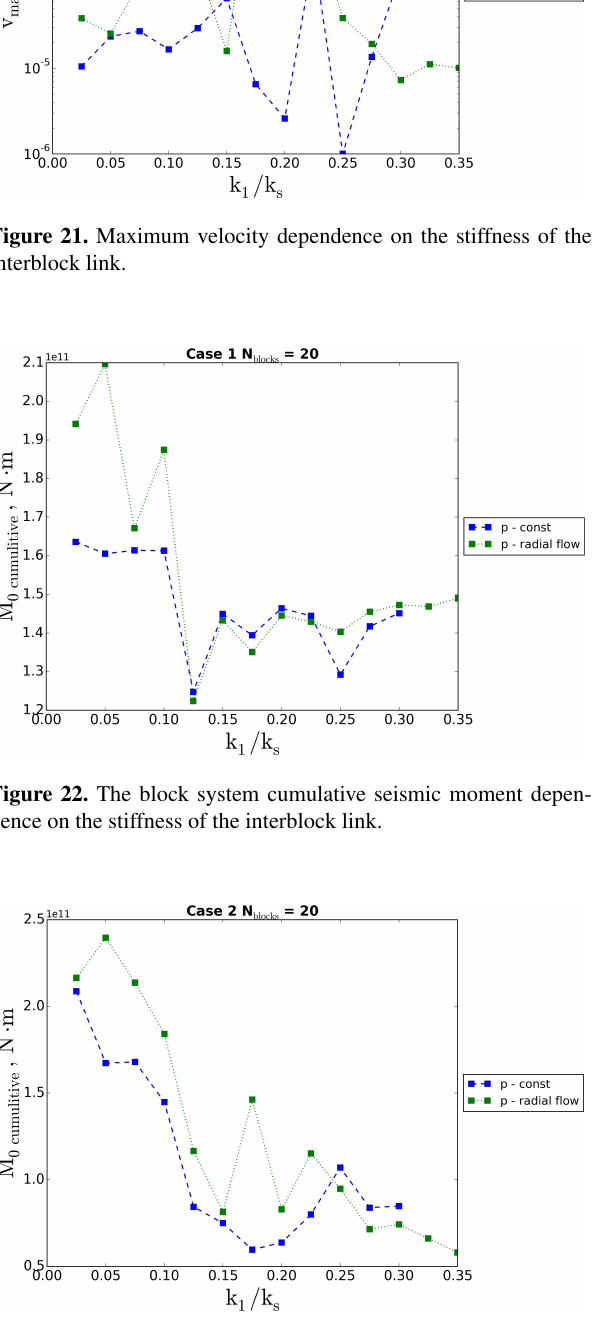
Figure 23. The block system cumulative seismic moment depen- dence on the stiffness of the interblock